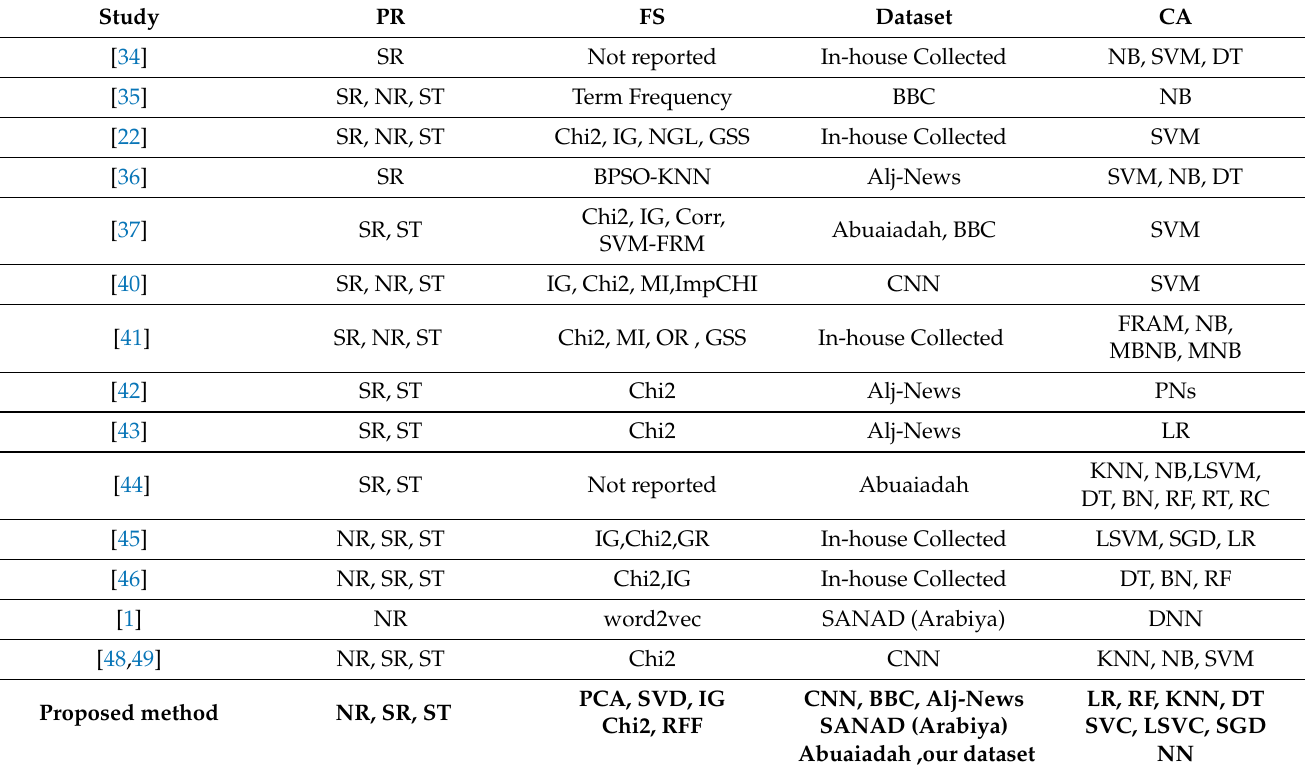
Table 1. Comparison with previous